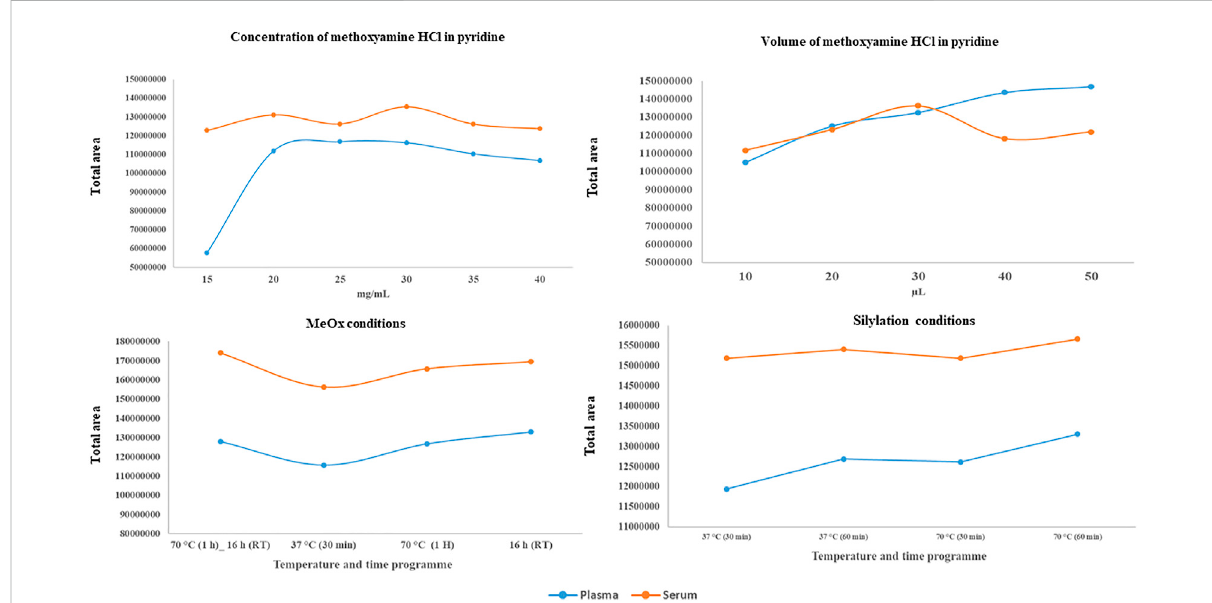
FIGURE 3 Effect of tested conditions on plasma and serum samples for all tested metabolites on the TI.